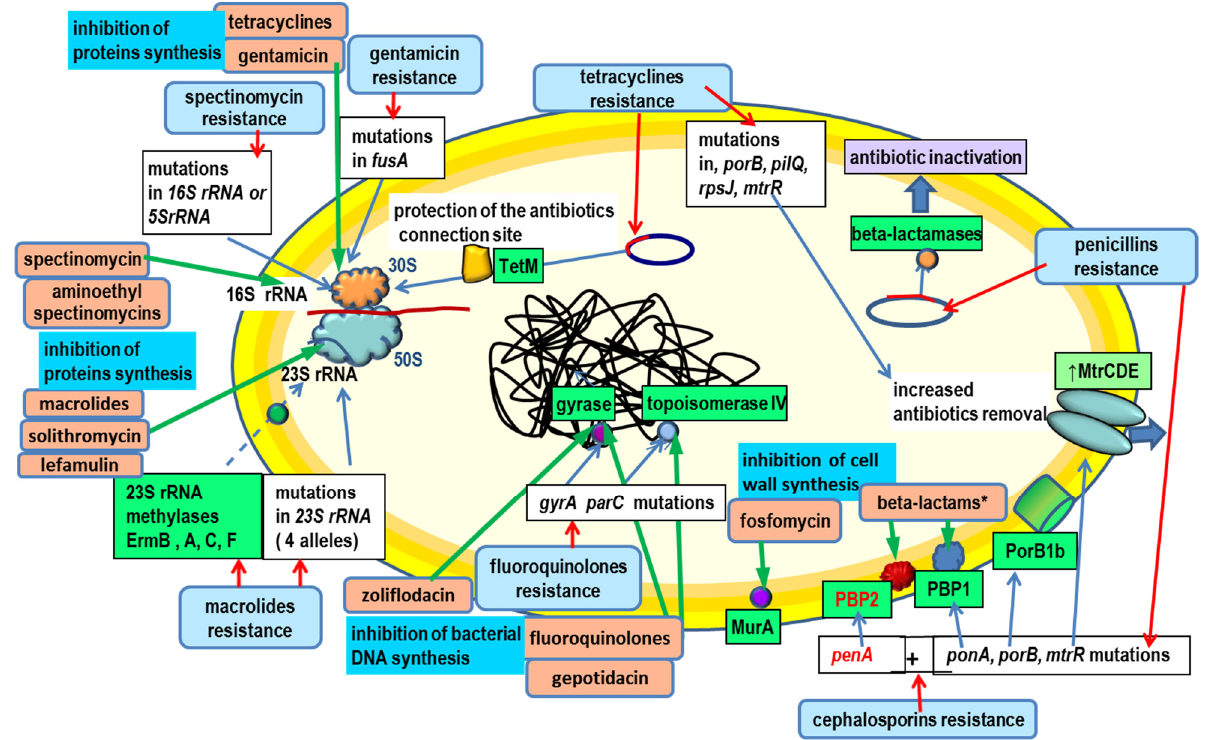
Figure 1. The most important targets of antibiotics (green arrows) and mechanisms of resistance (red arrows) in N. gonorrhoeae. See text for details. Beta-lactams*: penicillins, cephalosporins (ceftriaxone, cefixime), carbapenems